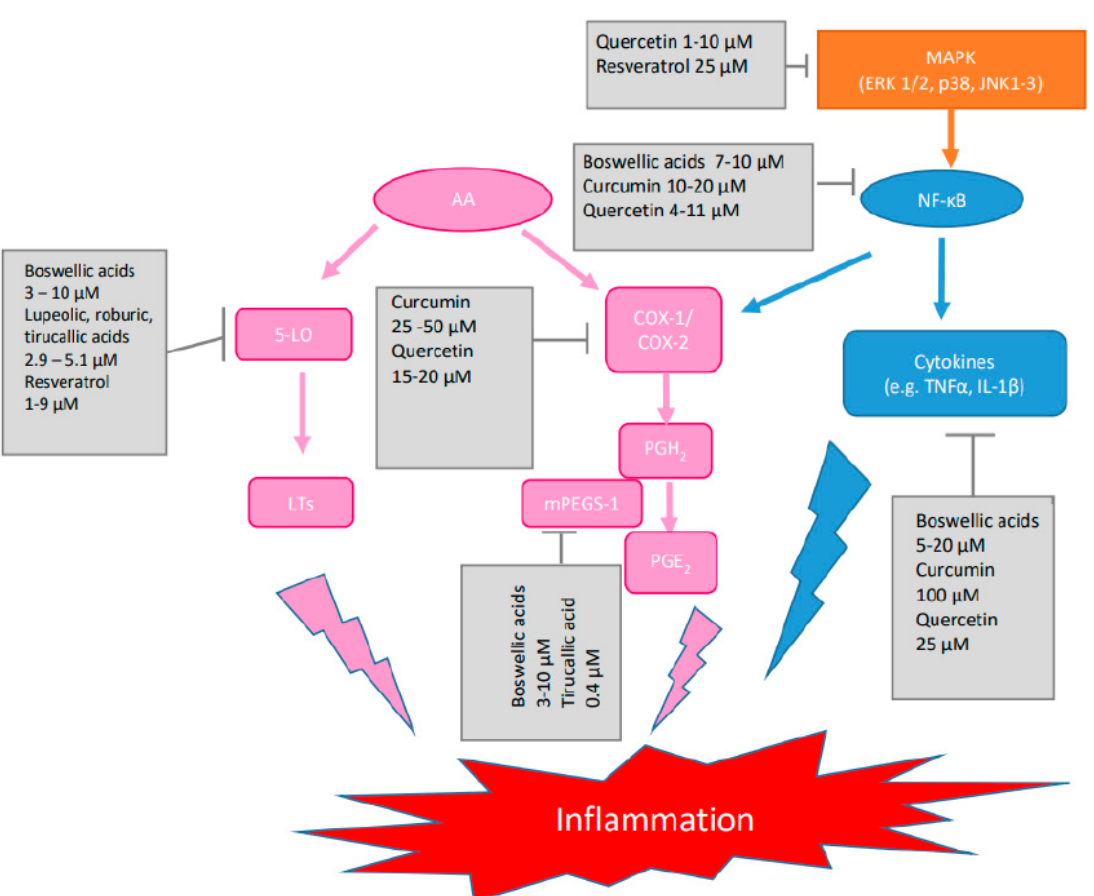
Figure 4. Simplified excerpt of the relation between different inflammatory mediators visualizing the point of attack of boswellic acids, curcumin, quercetin and resveratrol and the corresponding IC 50 values. AA = arachidonic acid, COX-1,-2 = cyclooxygenase-1, -2, ERK 1/2 = extracellular signal-regulated kinase 1/2, IL-1 β = interleukin 1 β , JNK1-3 = c-Jun-N-terminal kinase 1-3, 5-LO = 5-lipoxygenase, LT = leukotrienes, MAPK = mitogen activated protein kinase, mPGES-1 = microsomal prostaglandin E synthase-1, NF- κ B = nuclear factor ‘kappa-light-chain-enhancer of activated B-cells, PGE 2 = prostaglandin E 2 , PGH 2 = prostaglandin H 2 , TNF α = tumor necrosis factor α